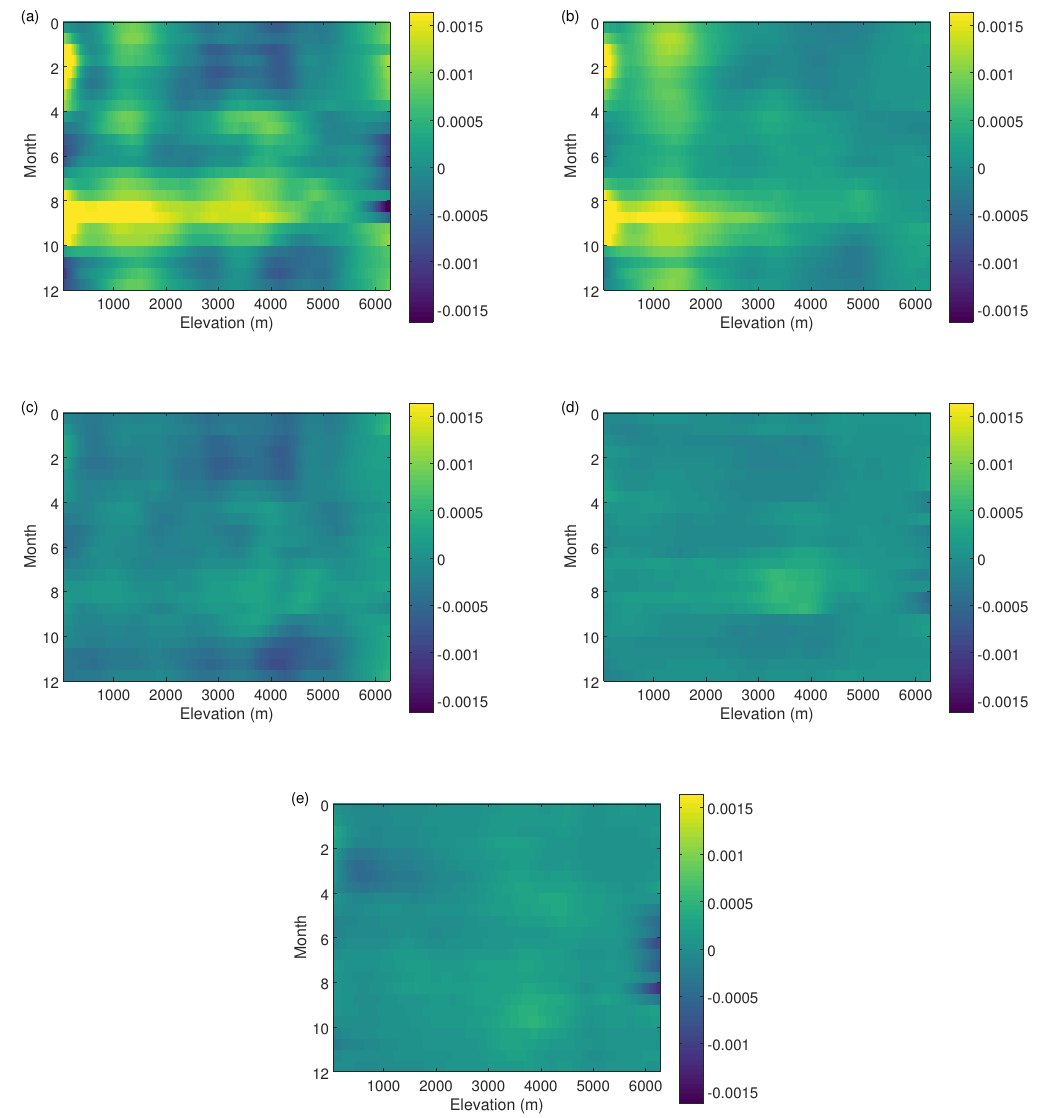
Figure 8. Modeled 1981–2015 linear trend in normalized difference vegetation index (NDVI; 10 − 3 per year) for Nepal, by season and elevation, with ( a ) all forcings, ( b ) only CO 2 -level change, ( c ) only land-use change, ( d ) only precipitation change, and ( e ) only temperature